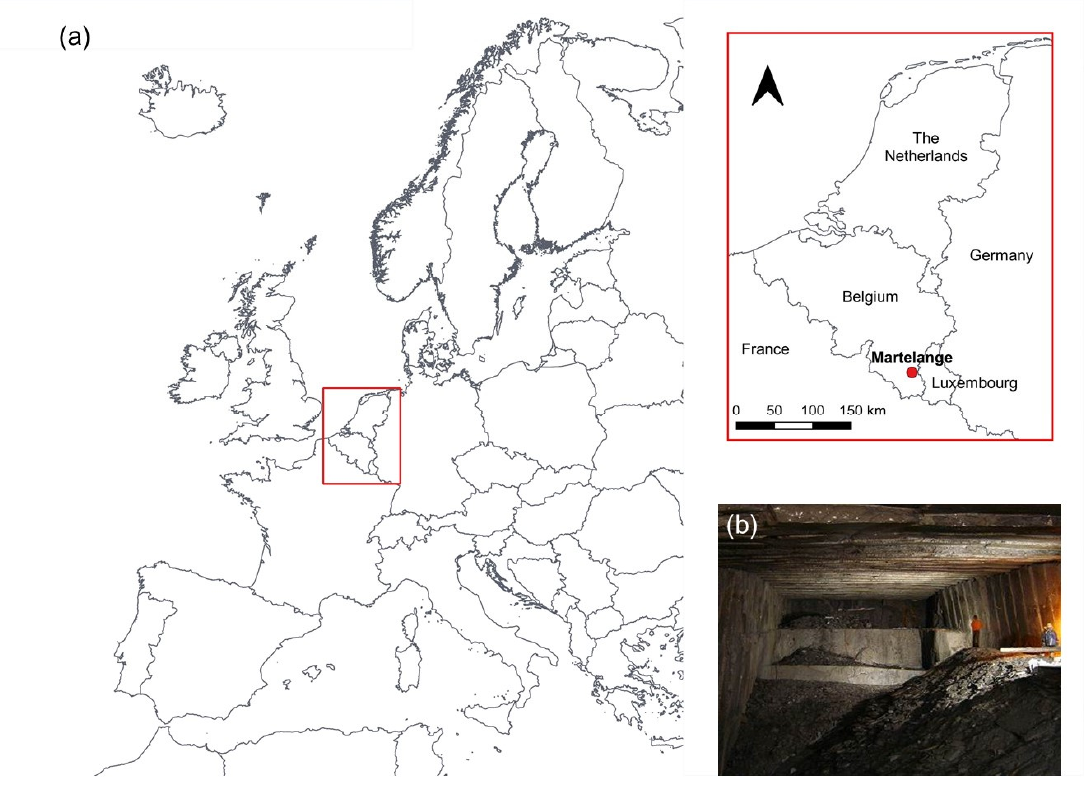
Figure 1. ( a ) Location of the Martelange mine in Belgium (map data obtained from EuroGeographics and UN-FAO) and ( b ) a typical chamber in the mine that could be used as a reservoir (( b ) courtesy of V. Duseigne, http://tchorski.morkitu.org/2/martelange-02.htm).